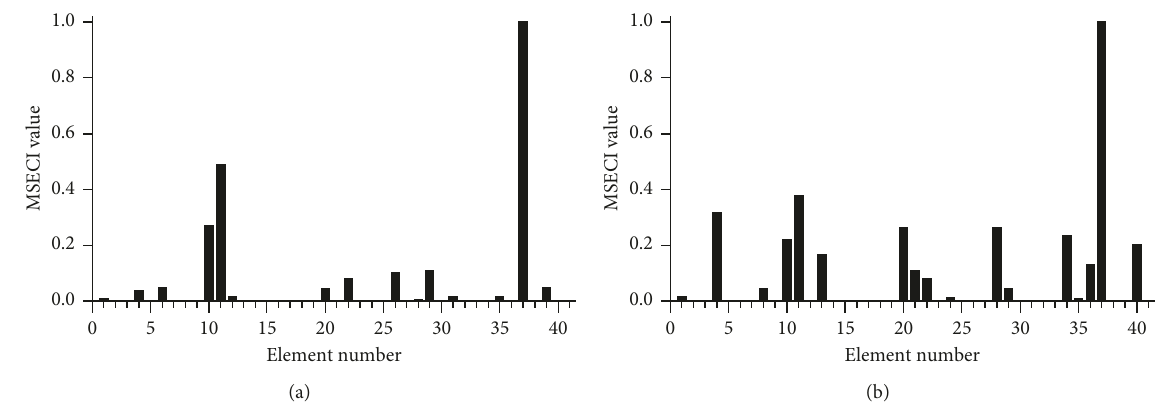
Figure 11: Values of the proposed MSECI using modes 1–8 (damaged element 11, 37). (a) Without noise. (b) With 5% noise. 020406080100 c t t e D e